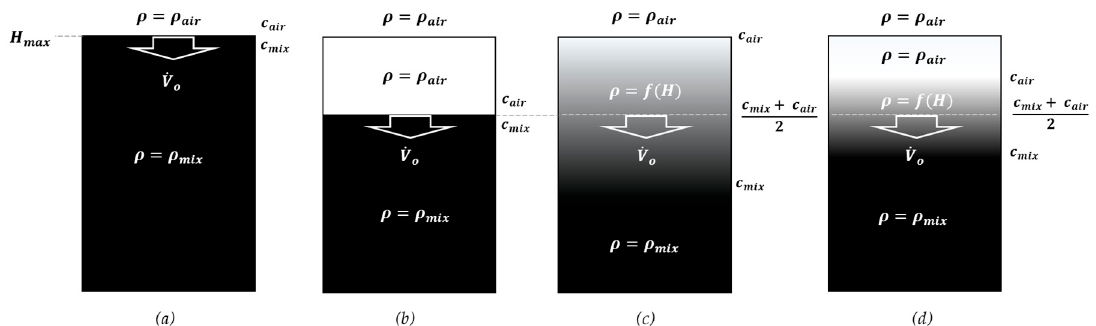
Figure 3. Schematic diagram of agent concentration distribution inside enclosure ( ρ mix > ρ air ) : ( a ) Initial concentration distribution interpreted as a homogeneous mixture after agent discharge. Agent concentration distribution from ( b ) the sharp model , ( c ) the wide model , and ( d ) the thick model . ( b – d ) show the agent concentration distribution when t = t h .